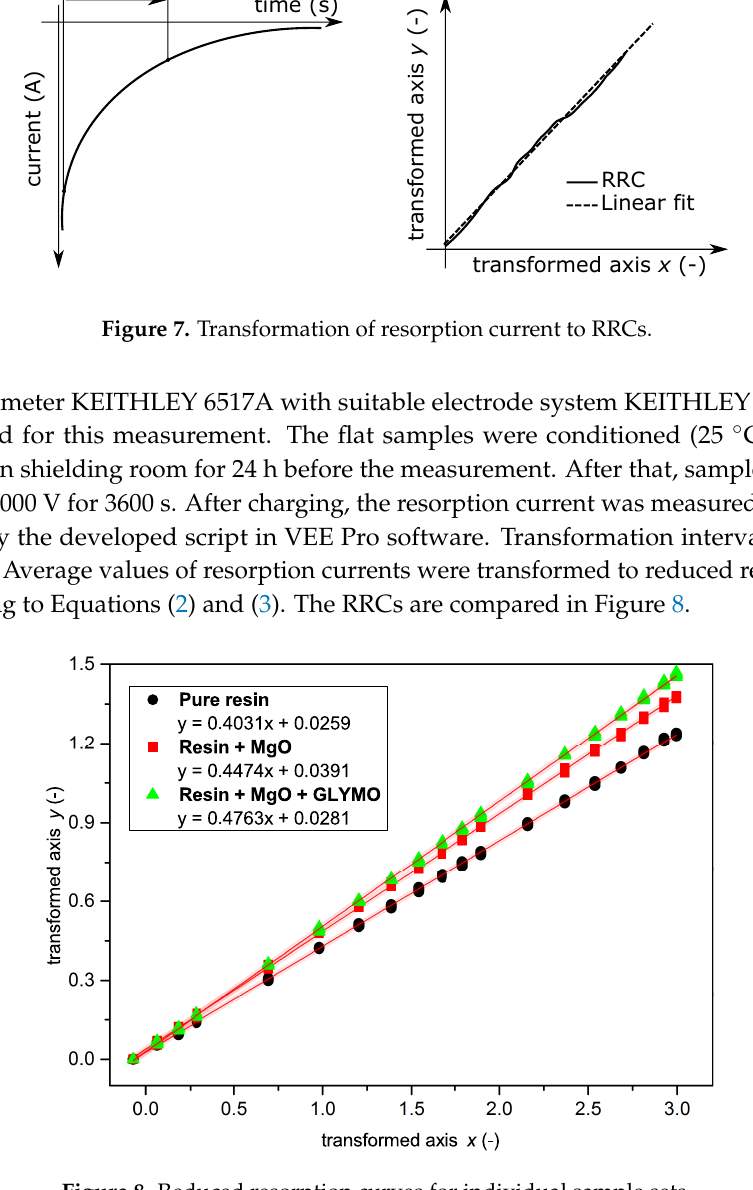
Figure 8. Reduced resorption curves for individual sample